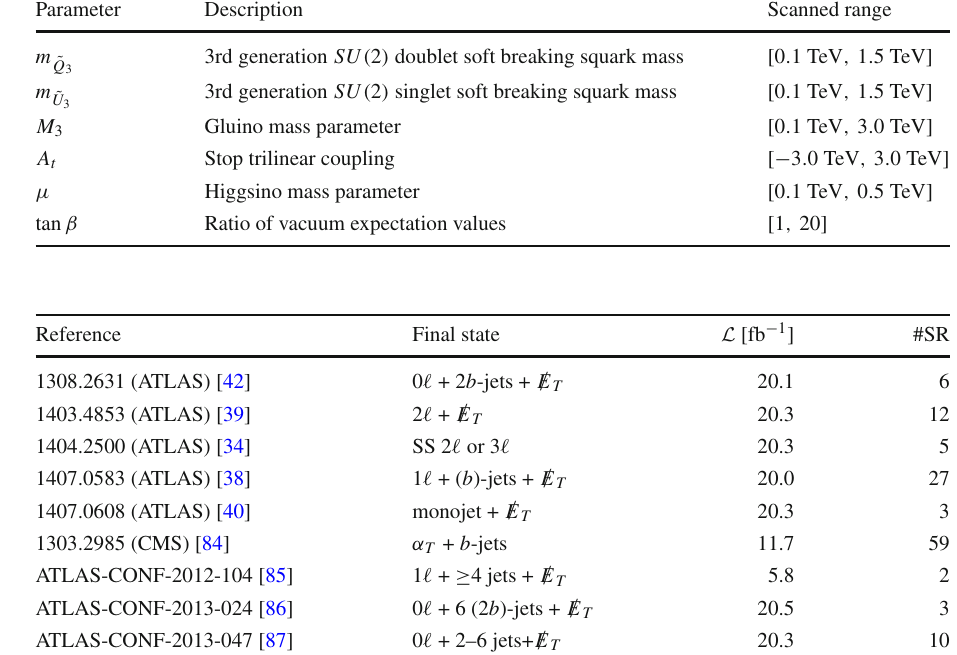
Table 6 Input parameters of the natural SUSY scenario of Ref. [76], and the range over which these parameters were scanned